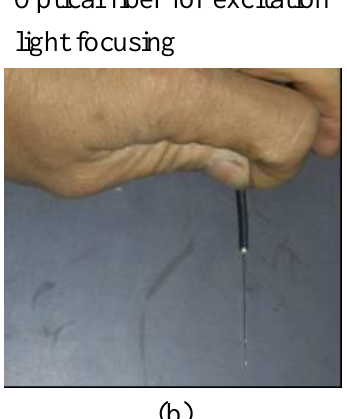
Optical fiber for excitation light